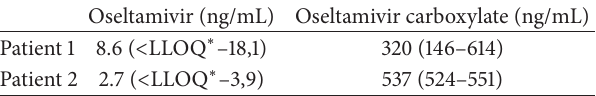
Table 1: Oseltamivir (carboxylate) plasma concentrations expressed as means (range). Concentrations were determined by a validated liquid chromatography tandem mass spectrometry